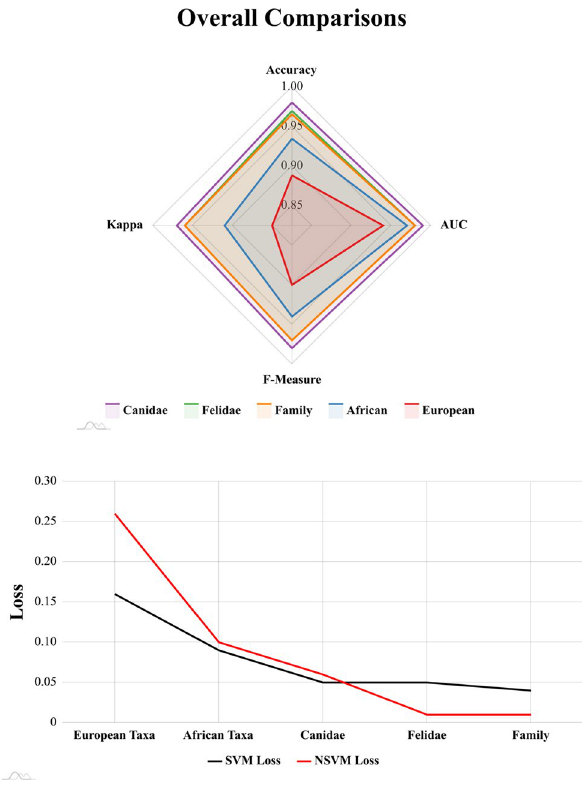
Figure 6. Top Panel: Radar plot summarising and comparing performance of the best computational learning models for each of the datasets. Bottom panel: Line graph representing the mean reported loss for both Support Vector Machines (SVM) and Neural Support Vector Machines (NSVM) on each of the datasets. Figure created using the amCharts4 JavaScript